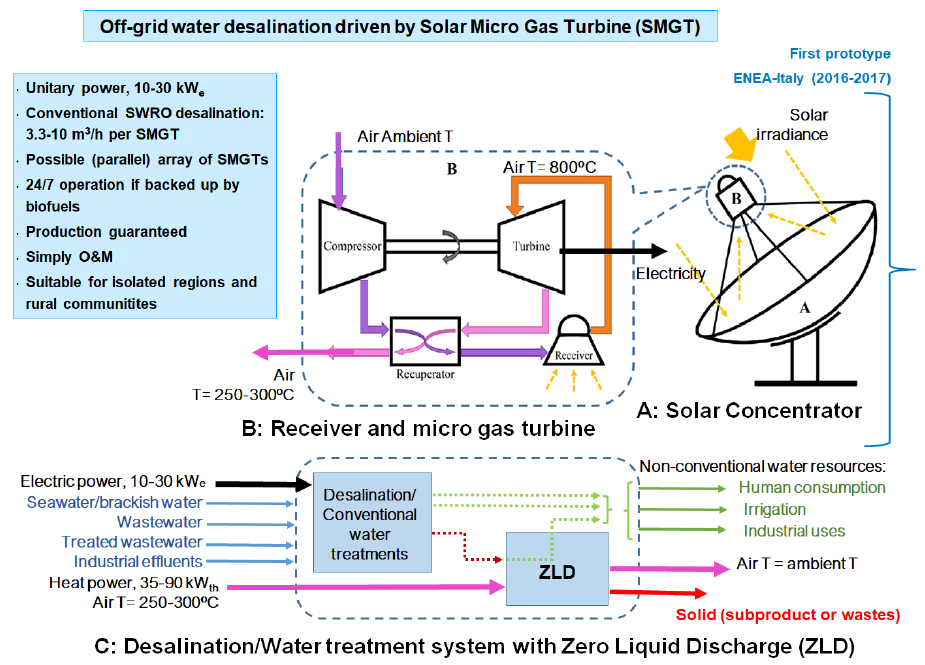
Figure 2. SOLMIDEFF technology. SWRO: SeaWater Reverse Osmosis. ZLD: Zero Liquid Discharge.